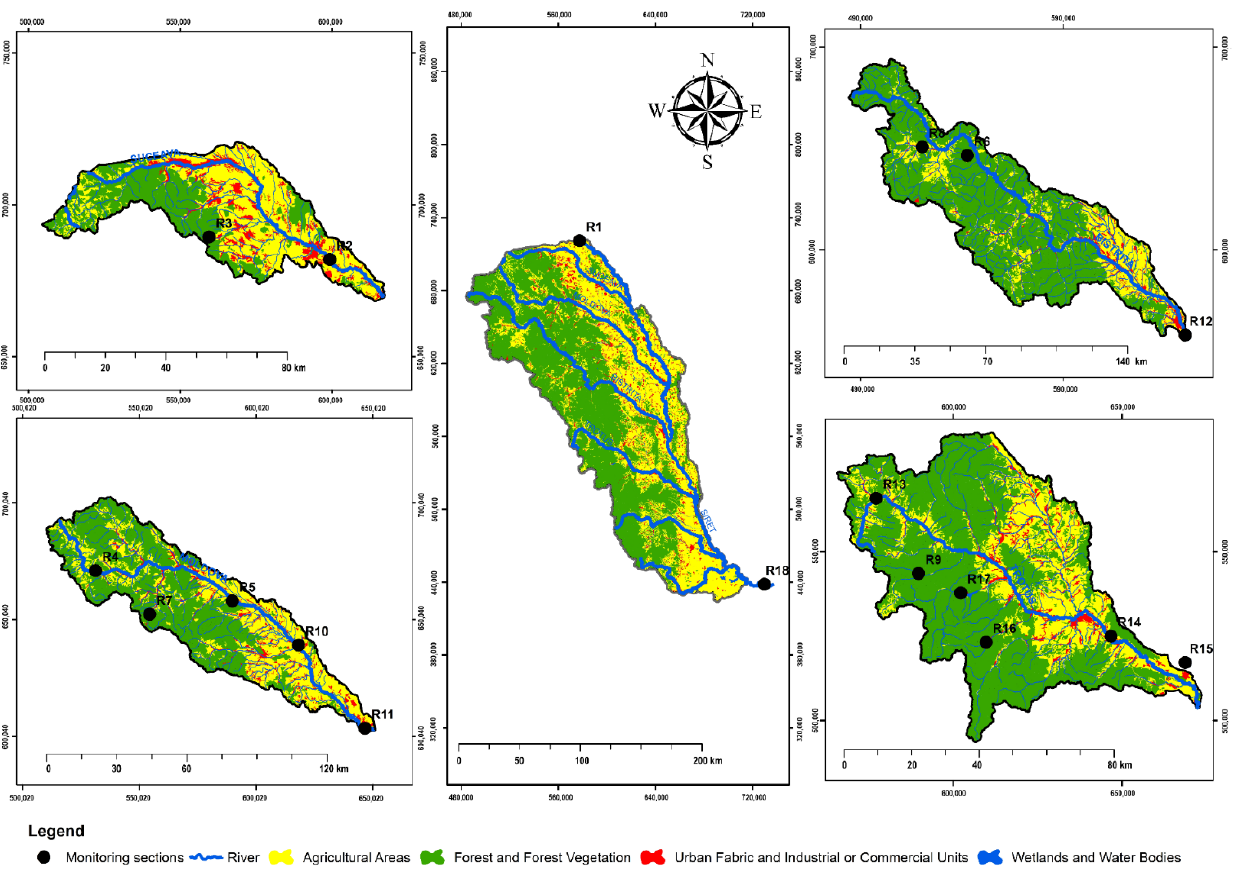
Figure 1. Siret river basin land use and water quality monitoring